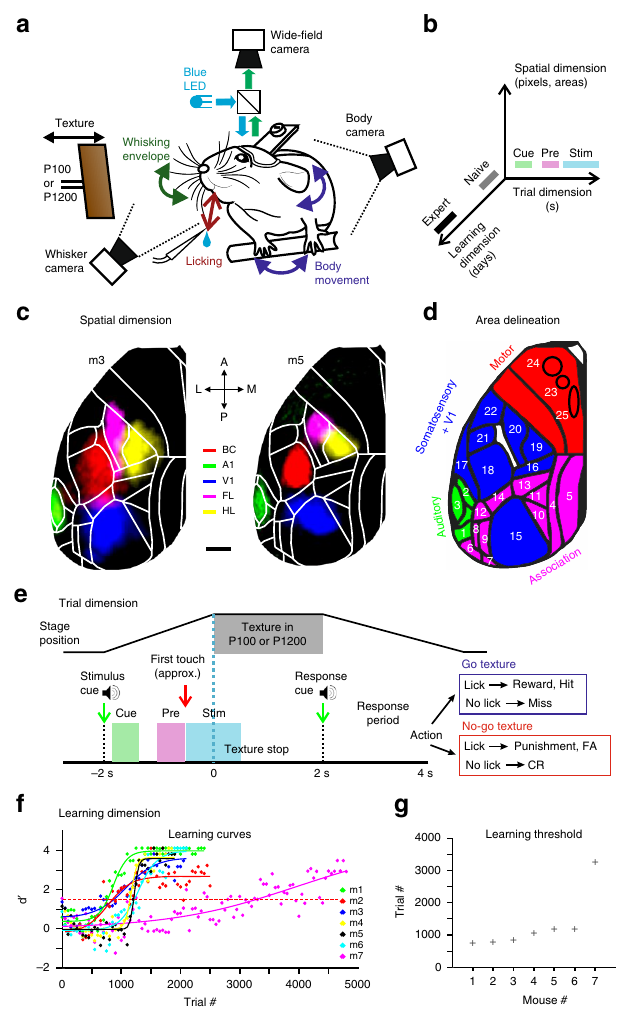
Fig. 1 Spatiotemporal dimensions relevant for texture discrimination learning. a Behavioral setup. b Schematic of the three relevant dimensions. c Functional maps for two example mice (m3 and m5) obtained by overlaying sensory-evoked activity maps for different sensory stimuli. Maps are registered to the Allen reference atlas (white outlines; ©2004 Allen Institute for Brain Science. Allen Mouse Brain Atlas. Available from: http://mouse. brain-map.org/). Scale bar is 1mm. d Area de fi nitions used in this study (see also Supplementary Fig. 1). Four rough divisions are auditory areas (green), association areas (pink), somatosensory + V1 areas (blue), and motor areas (red). e Trial structure and possible trial outcomes. After an initial auditory tone ( ‘ stimulus cue ’ ), the P100 or P1200 sandpaper approached and stayed in place for 2s. At withdrawal start, an additional auditory tone ( ‘ response cue ’ ) signaled the beginning of the report period. Cue-, pre-, and stim-period as analysis windows are marked by different colors. f Performance (d ′ ) for all mice across the entire learning period, fi tted with a sigmoid function. Red dashed horizontal line indicates threshold for learning (d ′ = 1.5). g Learning threshold for all mice in ascending